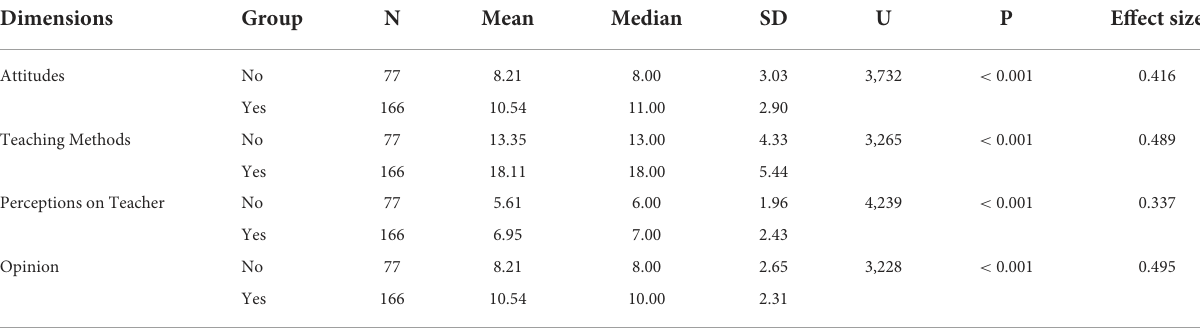
TABLE 8 Mann–Whitney U results according to usage of supporting course